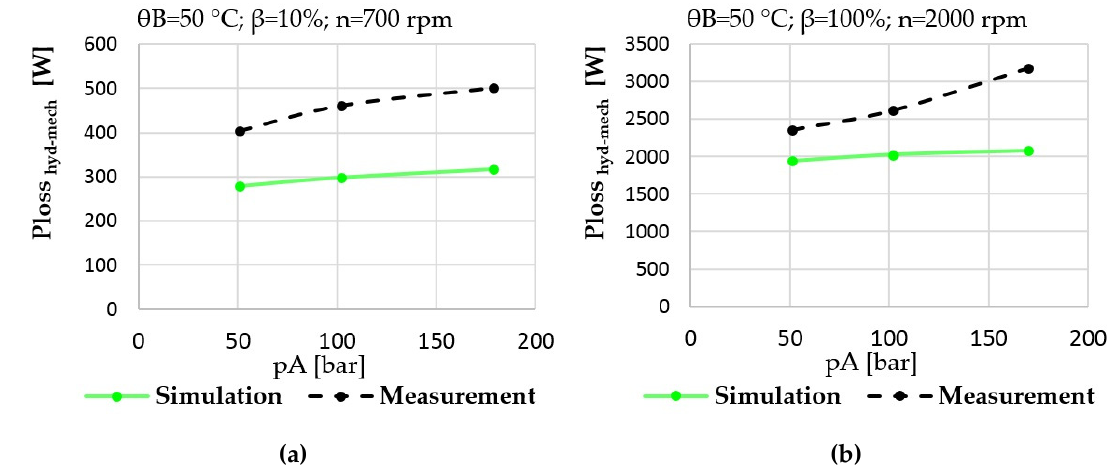
Figure 18. ( a ) Prediction vs. measurement; hydraulic-mechanical losses of the pump at low power operating condition; ( b ) prediction vs. measurement; hydraulic-mechanical losses of the pump at high power operating condition.